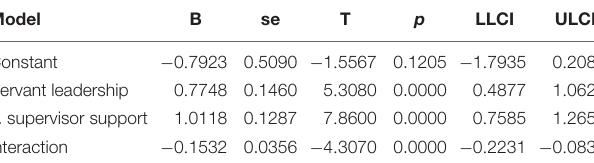
TABLE 5 | Moderation effect on psychological